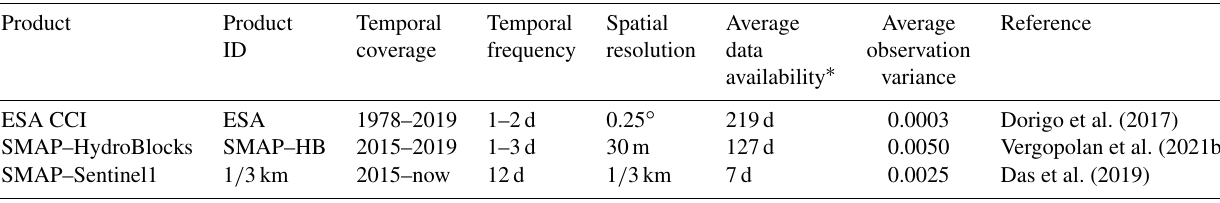
Table 1. Overview of remote sensing soil moisture data products. Product